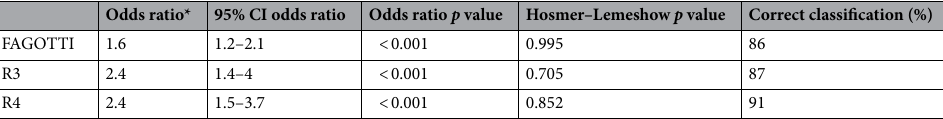
Table 4. Calibration analysis. Logistic regression: SCS and OCS versus Models scores. *Increased risk of suboptimal cytoreduction for each additional point.